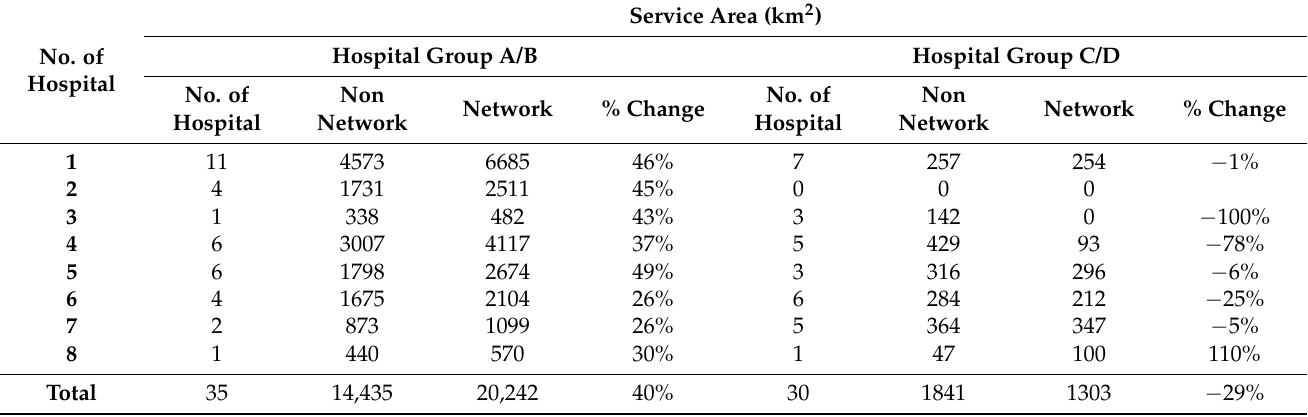
Table 6. Area comparison by non-network and network